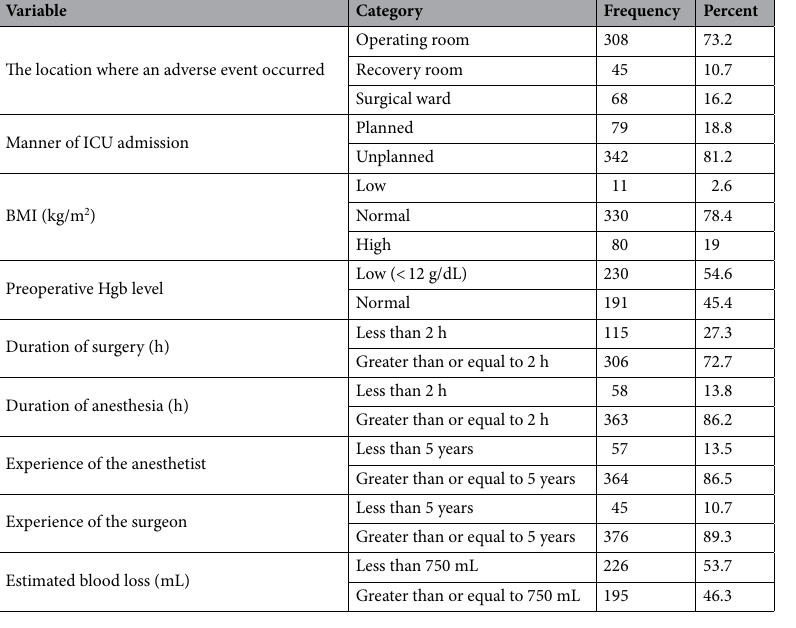
Table 2. Perioperative factors in patients admitted to ICU following surgery, 2021. ICU Intensive care unit, BMI Body mass index (normal = 18.5–24.9 kg/m 2 , low < 18.5 kg/m 2 , high > 24.9 kg/m 2 ), ml milliliter, min minute, g/dL grams per deciliter, Hgb Hemoglobin (normal = 12–15 g/dL, low < 12